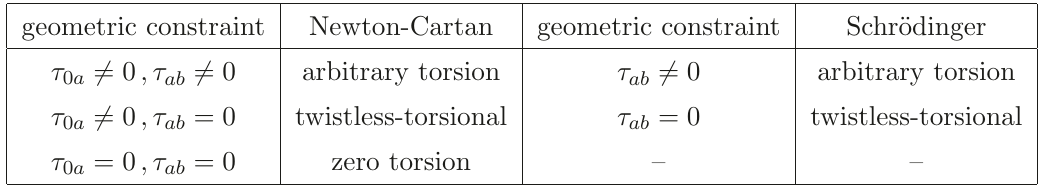
Table 1 . Newton-Cartan and Schr¨odinger geometry with